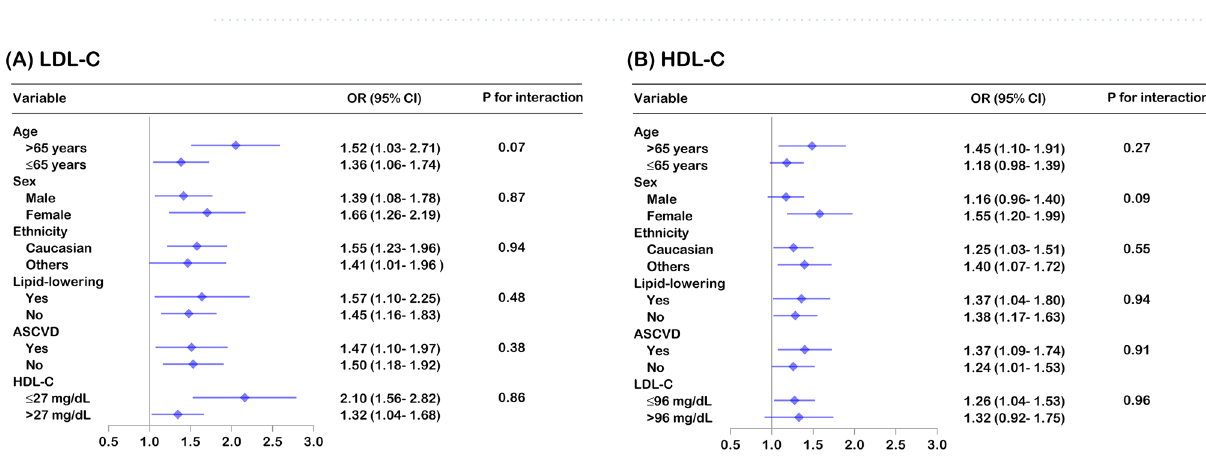
Figure 2. Probability of all-cause and cause-specific mortality based on LDL-C, HDL-C, total cholesterol and triglyceride levels. All-cause mortality ( A ), cardiovascular mortality ( B ) and noncardiovascular mortality ( C ) adjusted by age, sex, ethnicity, BMI, heart rate, mean blood pressure, disease severity score (APACHE score, Glasgow Coma Score), lab measurement (LDL-C, HDL-C, TC, TG, white blood cell, hemoglobin, platelet and albumin), primary disease of admission (circulatory disease, respiratory disease, digestive disease, neurological disease, genitourinary disease and endocrine disease), pre-admission comorbidities (ASCVD, diabetes, hypertension, heart failure, COPD and renal dysfunction), medication (lipid-lowering therapy, antiplatelet drug and anticoagulant), mechanical ventilation and dialysis.